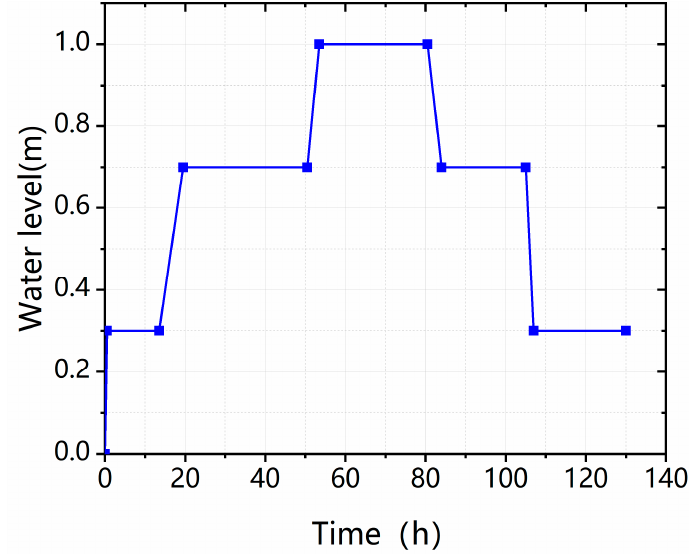
Figure 9. Curve of the regulation of the reservoir water level. The actual measured volumetric water content of the landslide model ranged from 5% to 50% within the design conditions of the laboratory test, and the soil water content of the landslide gradually increased as the water levels of the reservoir rose and water gradually infiltrated the landslide during the rising phase of reservoir water levels. As shown in Figure 10, a slight difference was found between the values of volumetric water content obtained from the equations fitted in this study and the actual monitored volumetric water content. Moreover, the predicted values were distributed around the actual monitored values, and the root mean square error of the model was only 0.0211. Therefore, the inversion of the resistivity model is suitable and has a certain reliability.